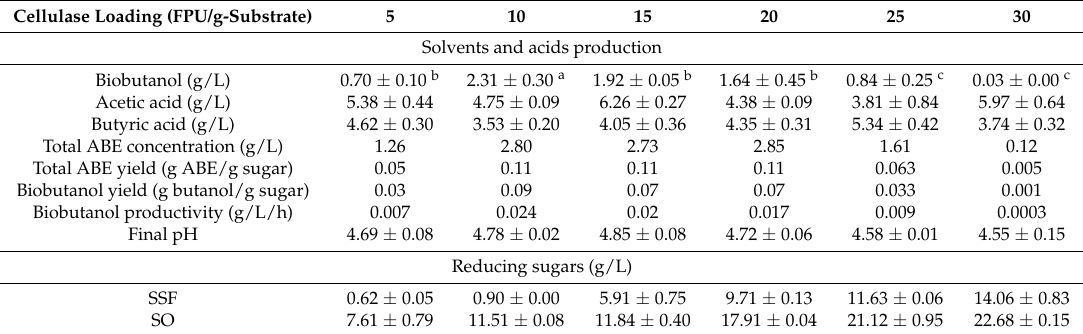
Table 3. Effect of cellulase loading (5–30 FPU/g-substrate) on biobutanol production at 35 ◦ C, initial pH 5.5 and 5% ( w / v ) substrate on simultaneous saccharification and fermentation by Clostridium acetobutylicum ATCC